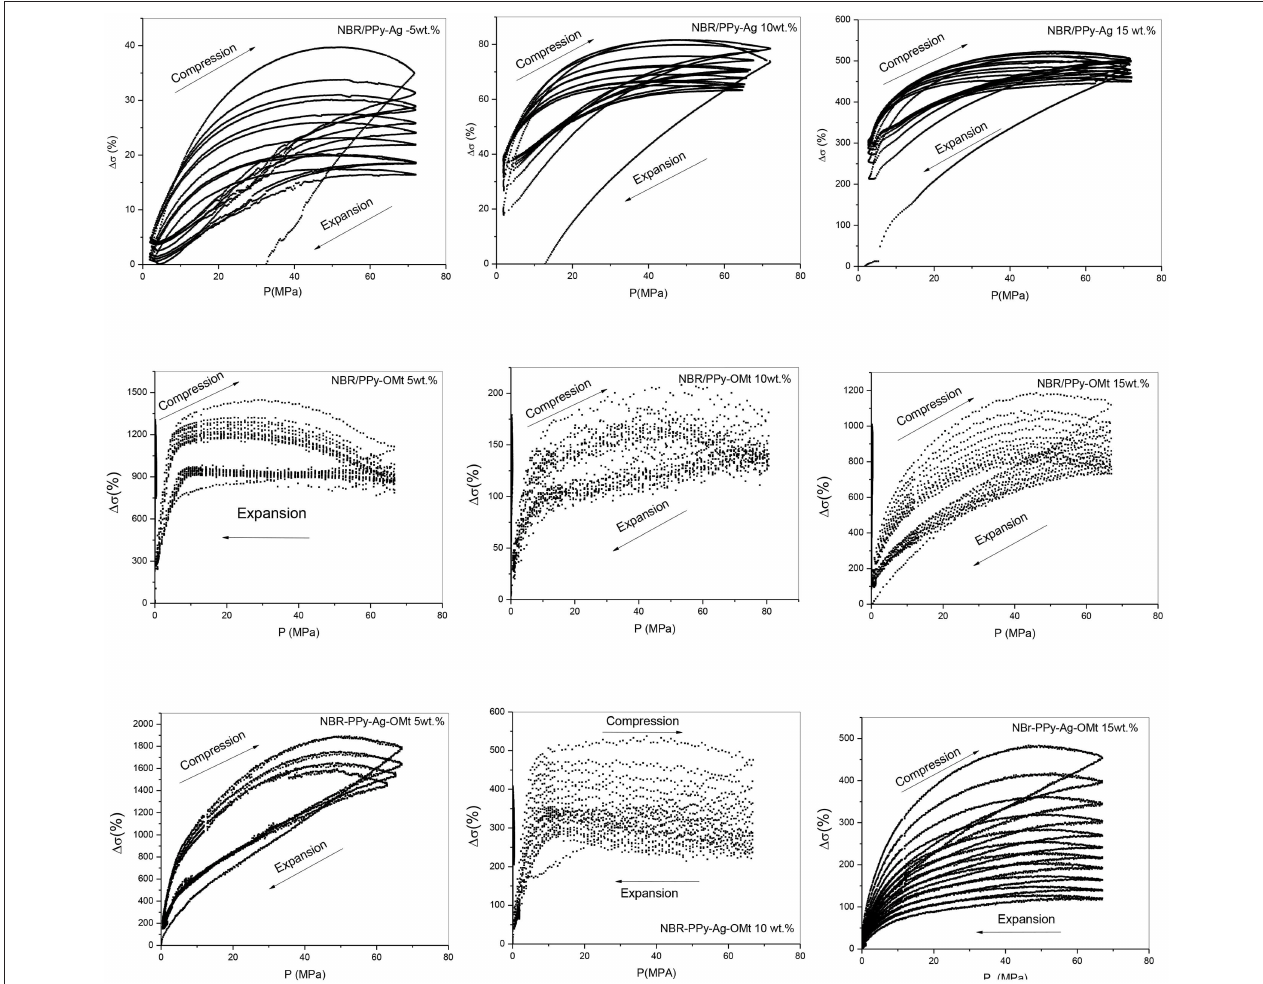
FIGURE 3 | Compression–expansion curves of NBR-PPy-Ag, NBR-PPy-OMt, and NBR-PPy-Ag-OMt.